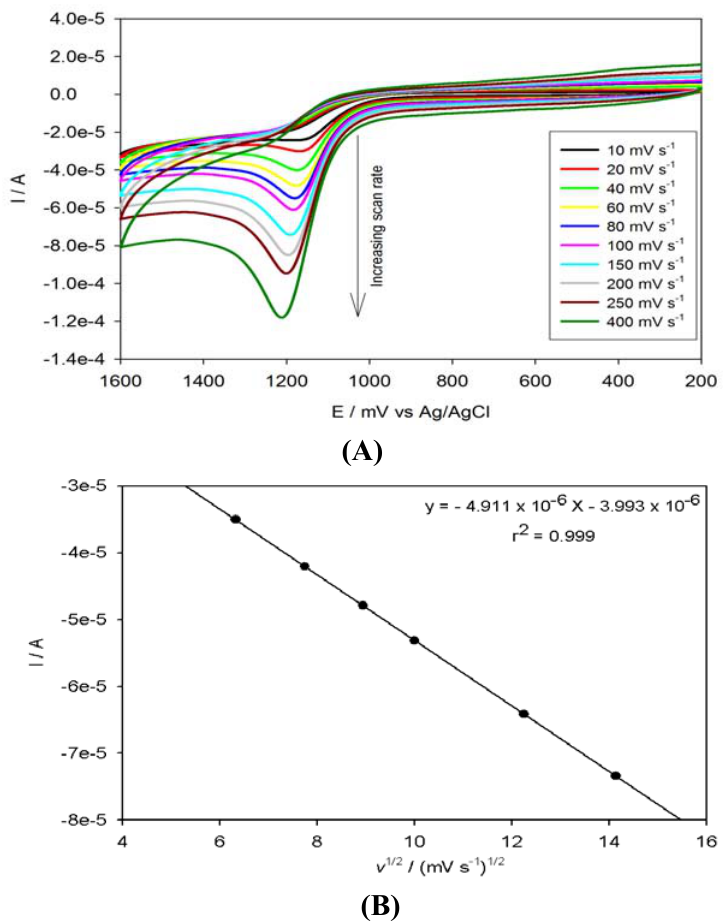
Figure 8. CVs of PPyox/Ag-AuNPs/GCE upon addition of 3.56 × 10 − 4 M anthracene at different scan rates (A) and a plot of root scan rate versus peak current (B)